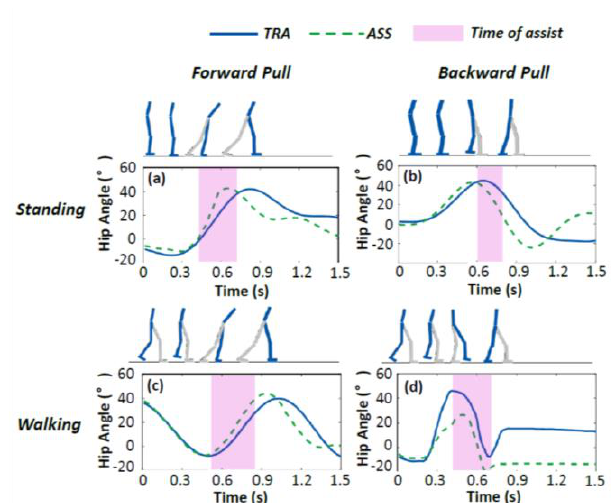
Figure 15. The hip joint angle.